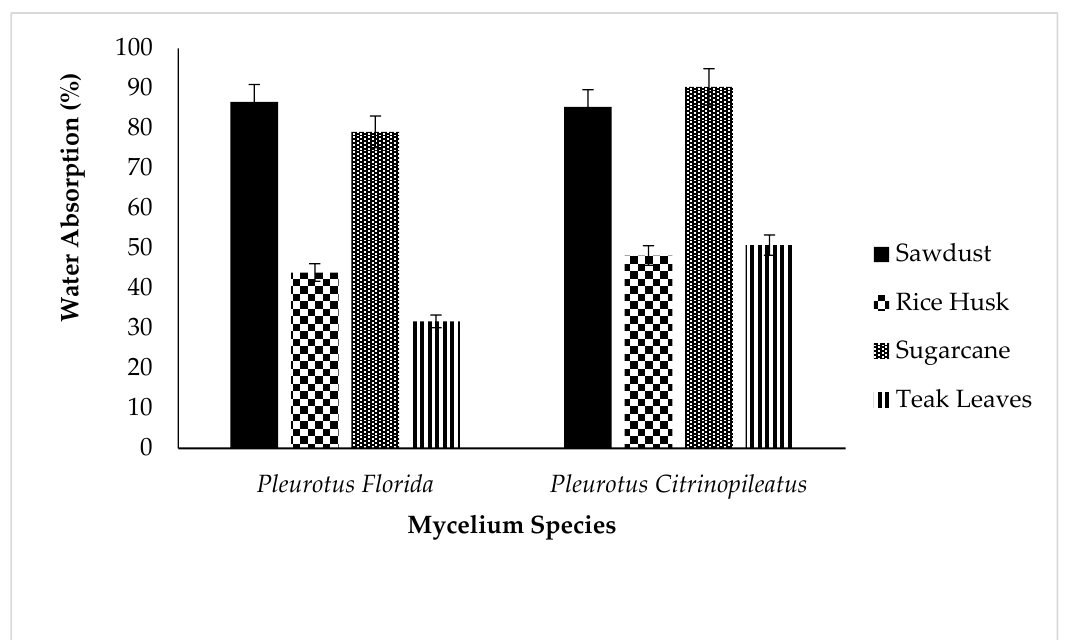
Figure 10. Water absorption of fungal foam from Pleurotus florida and Pleurotus citrinopileatus in different substrates. Table 2. Hemicellulose content of different substrates.